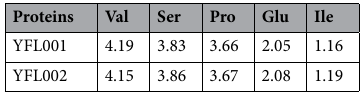
Table 4. Proton amino acid shifts by NMR.